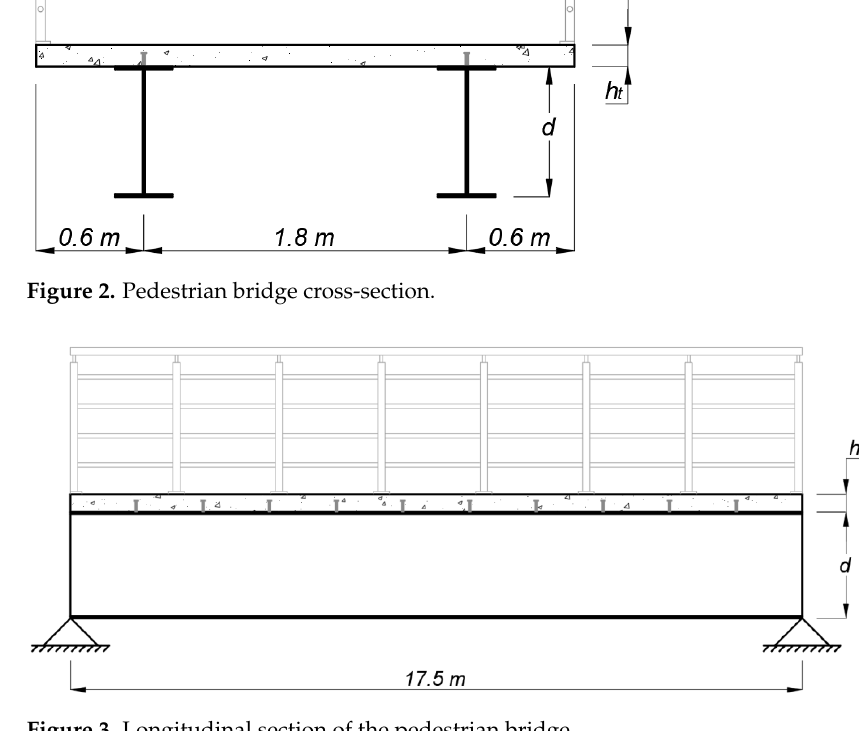
Figure 3. Longitudinal section of the pedestrian bridge.